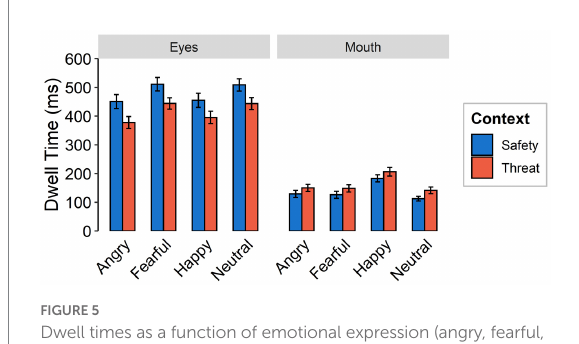
FIGURE 5 Dwell times as a function of emotional expression (angry, fearful, happy, and neutral) and context (threat, safety) onto the eye or mouth region (feature) of a presented face. Error bars indicate standard error of the